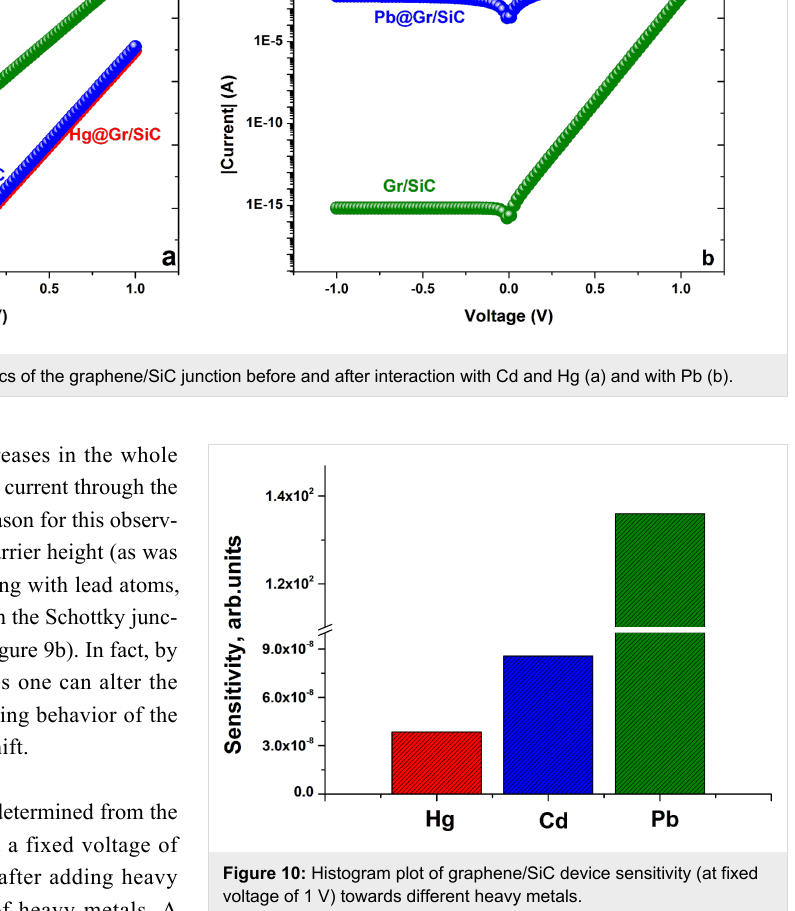
reaches a minimum and then it increases upon increasing the Pb concentration further. The dependence of the ratio on Cd and Hg concentration is very weak, therefore no significant change in current compared to the pristine graphene cluster is